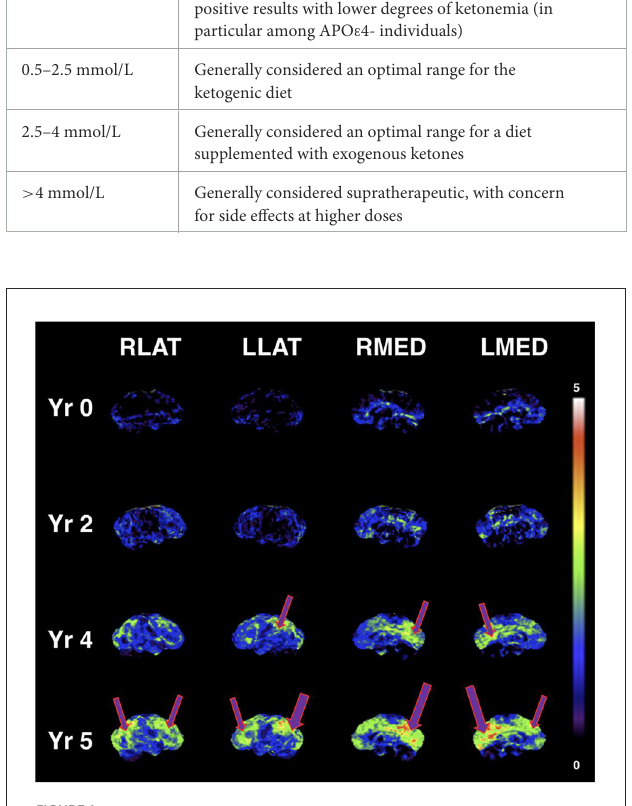
cognitive impairment (Yr 2 and Yr 4), and clinical diagnosis of dementia (Yr 5) in PD dementia converter. Cortical Z-score maps based on normal control data are shown (max Z-score is 5; higher scores represent more severe glucose metabolic deficits). Purple arrows represent reduced glucose metabolism. Similar to worsening metabolic deficits seen in MCI and AD, cortical glucose metabolic reductions become more severe and extensive with progression of cognitive decline (in this case, glucose uptake in key brain regions such as the posterior cingulum and precuneus is ∼ 3–5 standard deviations lower than control data at Yr 5). According to the “alternative fuel” hypothesis, escalating dose or potency of ketogenic interventions may be needed for greater brain metabolic deficits (greater brain energy “gap”). Figure reproduced with permission from Bohnen et al.